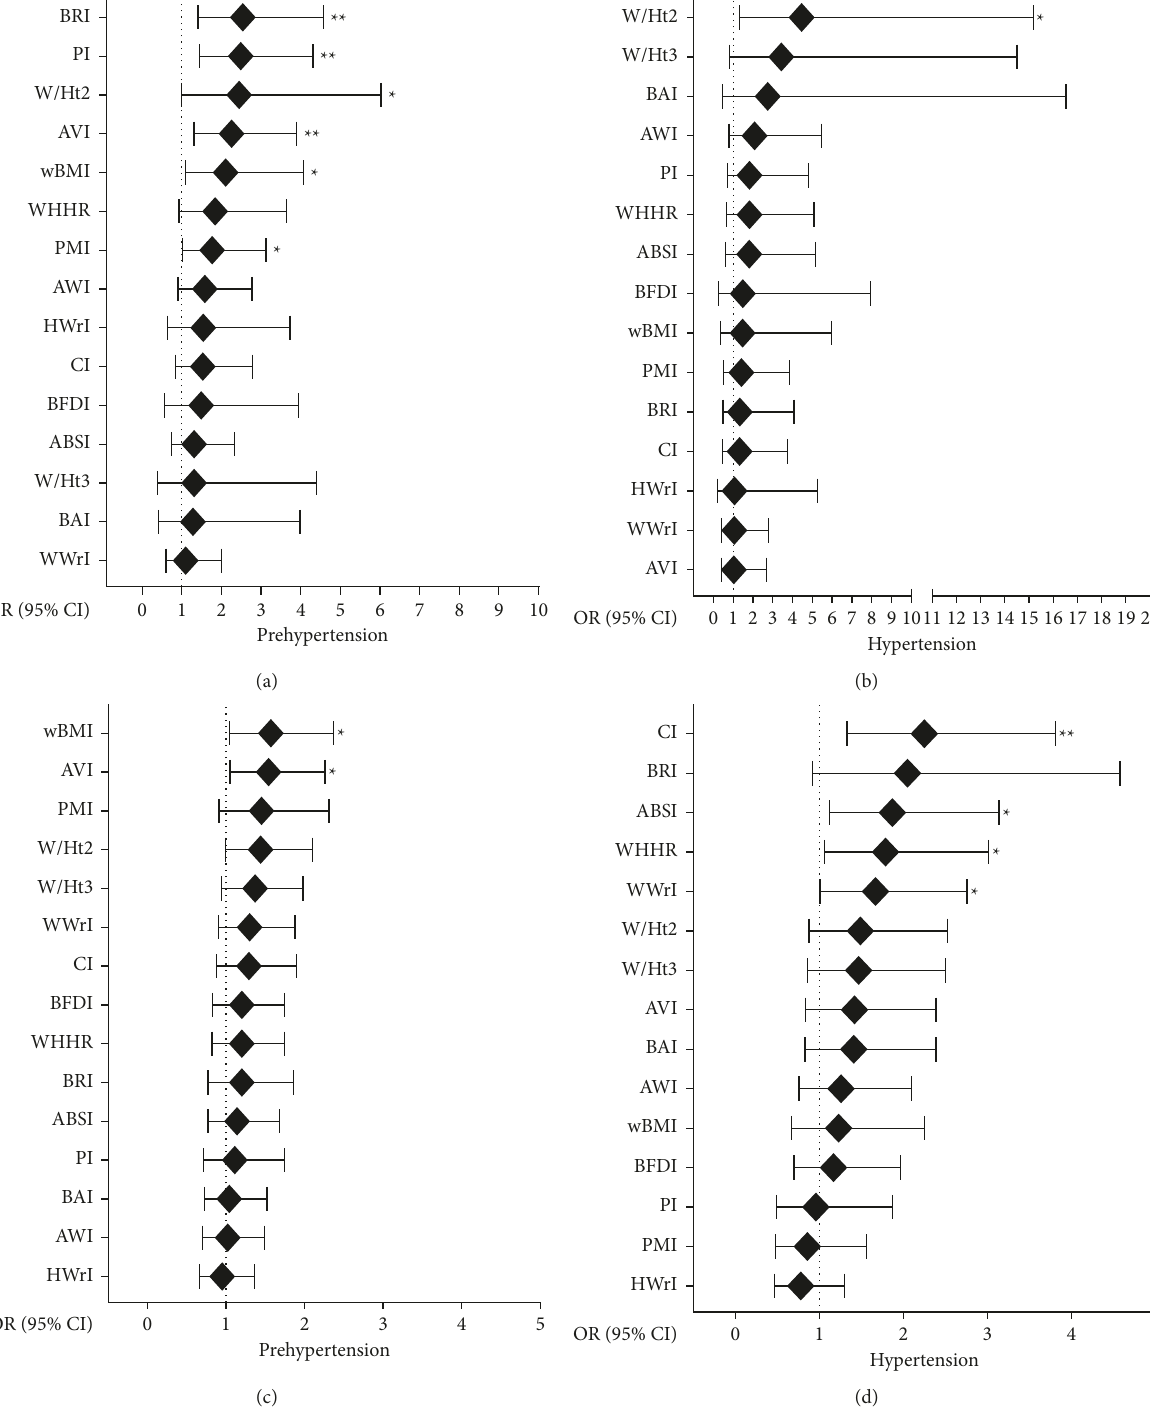
Figure 1: Association of emergent anthropometric indices with preHTN and HTN in men (a, b) and women (c, d). ABSI, a body shape index; AVI, abdominal volume index; AWI, arm-waist index; BAI, body adiposity index; BFDI, body fat distribution index; BRI, body roundness index; CI, conicity index; Ht 3 /W 3 , height cubic to waist cubic; HWrI, hip-wrist index; PI, ponderal index; PMI, pulse mass index; wBMI, waist corrected BMI; WWrI, waist-wrist index; WHHR, waist to hip to height ratio; W/Ht 2 , waist to height square; W/Ht 3 , waist to height cubic. Data shown represent the odds ratio (confidential interval of 95%). Model adjusted by age. statistically